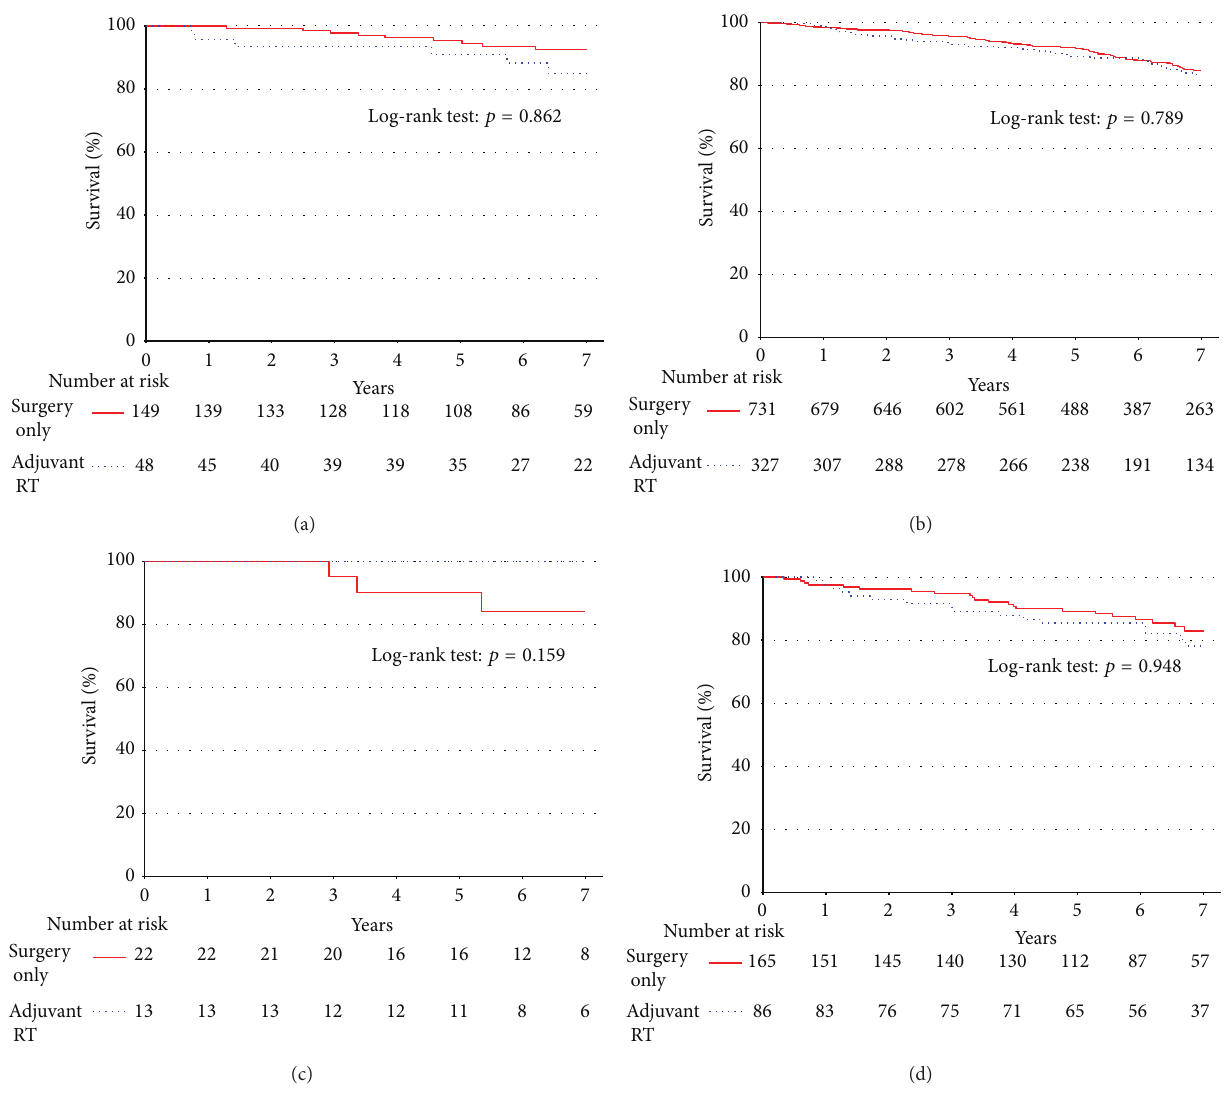
Figure 6: There is no difference in unadjusted survival for patients with well-differentiated liposarcoma tumors when stratified by adjuvant RT versus surgery on the basis of size < 5cm (a) and > 5 cm (b) for patients with negative margin status. There was also no difference when stratified on the basis of size in patients with positive margin status ((c) and (d),